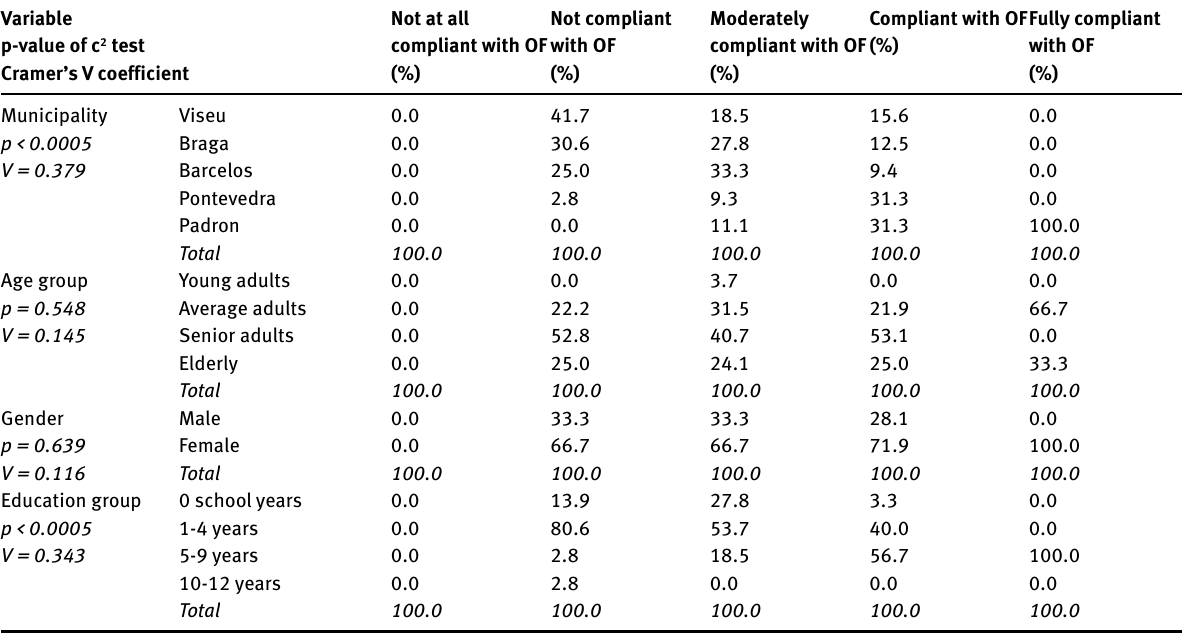
Table 3: Associations between the variable compliance with OF regarding cultural interventions (CPOF-C) and the socio-demographic variables Variable